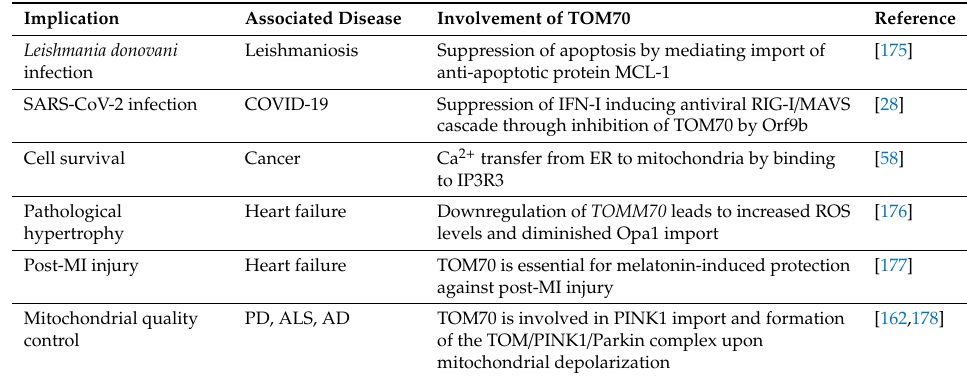
Table 2. Implications of TOM70 in human health and